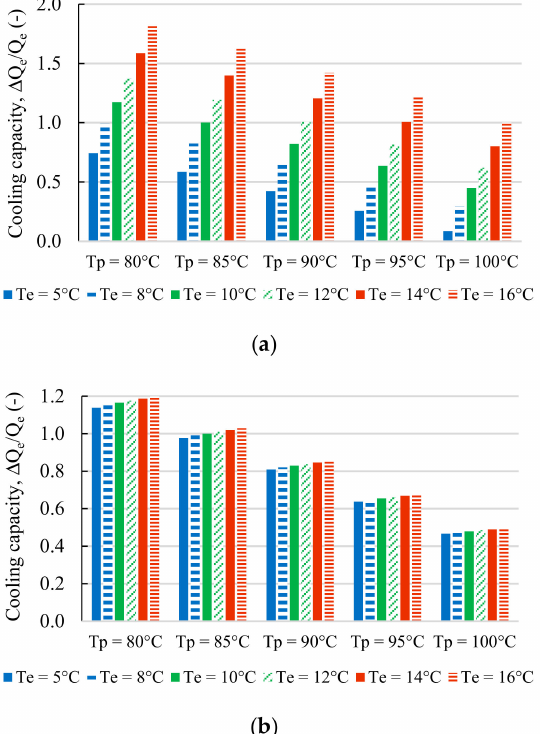
Figure 9. Sensitivity of refrigeration sub-system cooling capacity as a function of the evaporator and primary flow inlet (generation) temperature for the simple Ejector A cycle and the compression- assisted Ejector C cycle with R245fa as the working fluid, normalized to a baseline capacity of T p = 85 ◦ C and T e = 10 ◦ C: ( a ) Ejector A (SC); ( b ) Ejector C